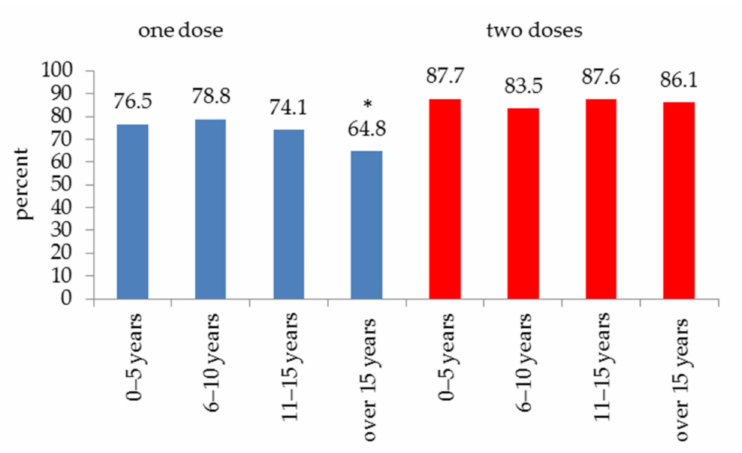
Figure 1. Positivity of mumps antibodies over time after one or two doses of vaccine. A significant (* p < 0.0001) waning of antibodies was observed after 15 years but only if one dose of vaccine was